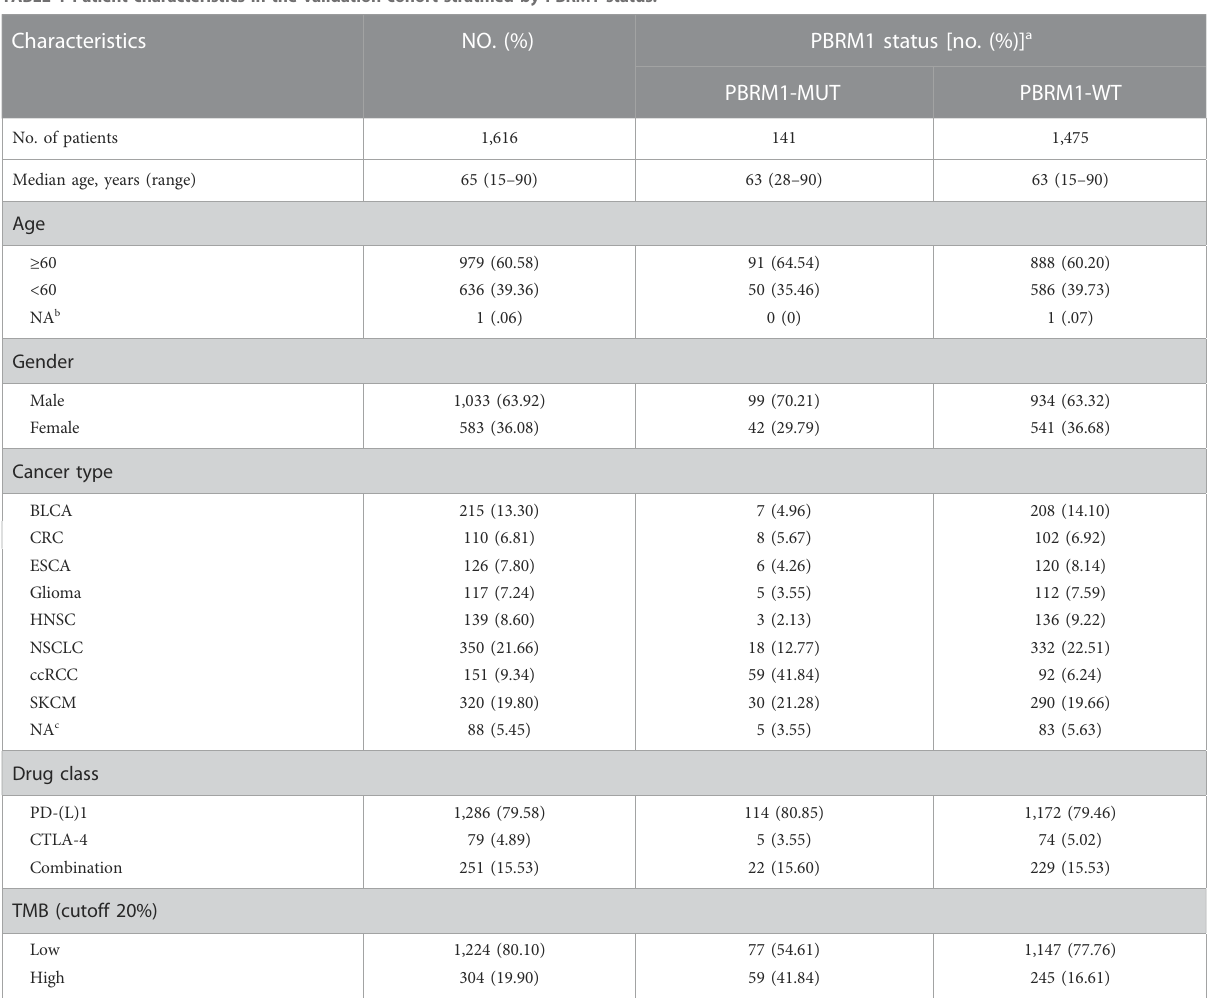
TABLE 1 Patient characteristics in the validation cohort strati fi ed by PBRM1 status.